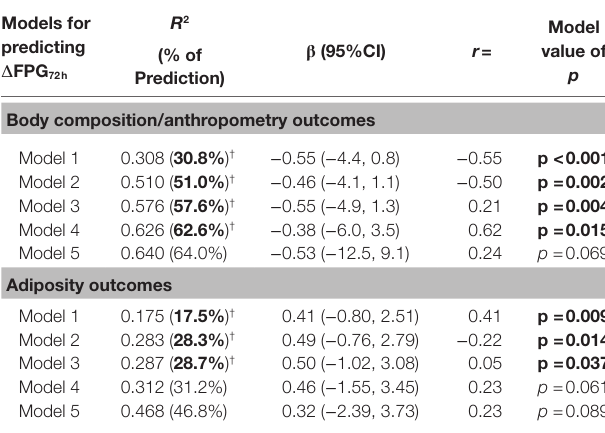
TABLE 4 | Body composition/anthropometric and adiposity outcomes (delta changes) predicting the changes in FI from post-24 h to post-72 h in participants after 12-weeks of concurrent